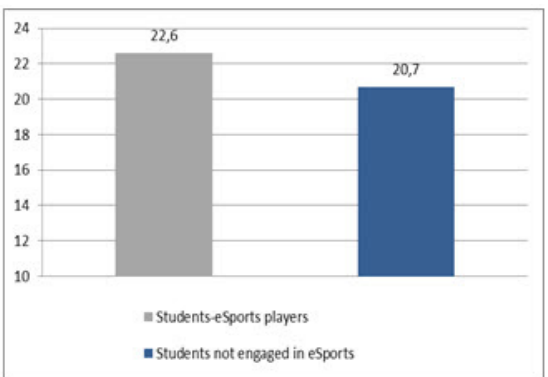
Figure 2. Results of diagnostics of the level of general mental abilities of eSports stu- dents and non-eSports students ESports students have a lower level of critical thinking than non-eSports students (U = 124,500, ≥ 0,05).